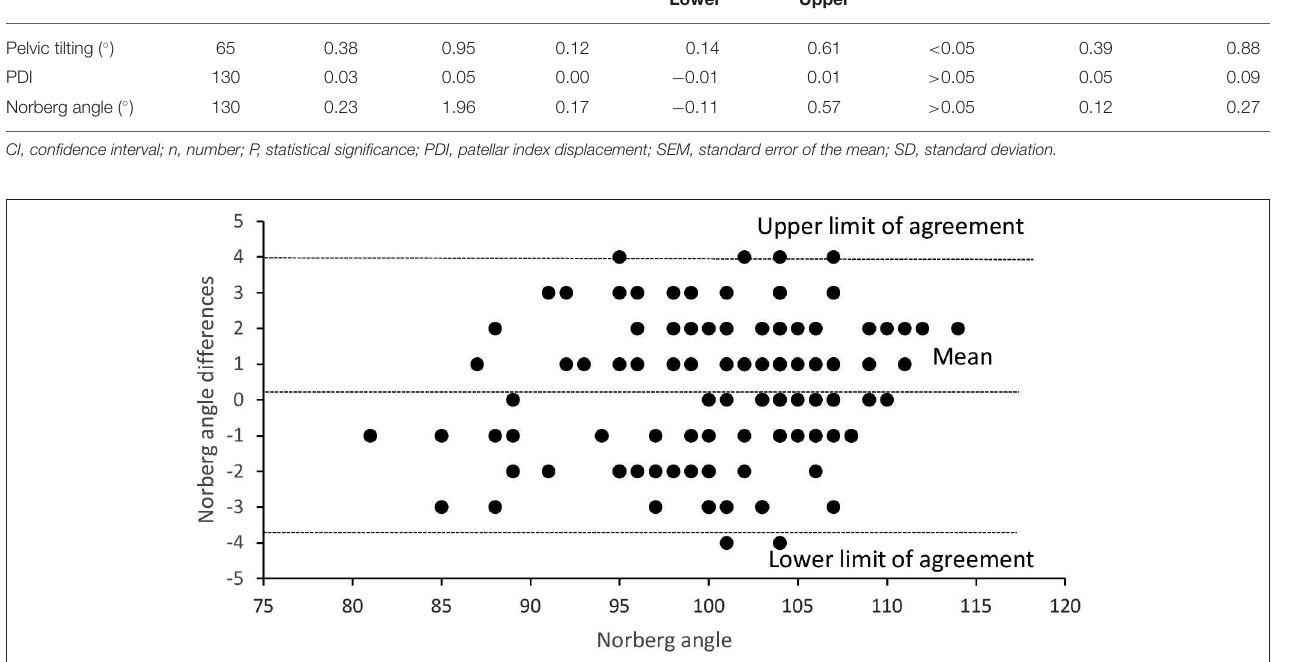
FIGURE 3 | Differences between Norberg angle on examiner restraining radiographic views and on hands-free holder device views plotted against the Norberg angle examiner